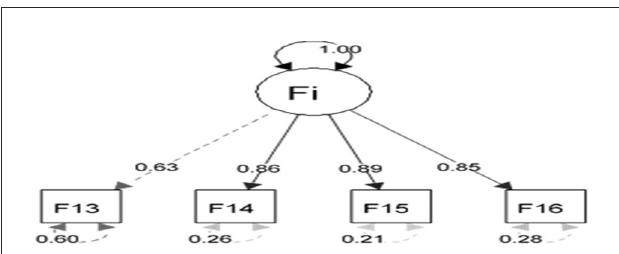
FIGURE3 Confirmatory factor analysis model of the financial dimension of the family support for older people questionnaire. All items in the questionnaire showed a factor load > 0.3, indicating appropriate metrics for the tool factor.